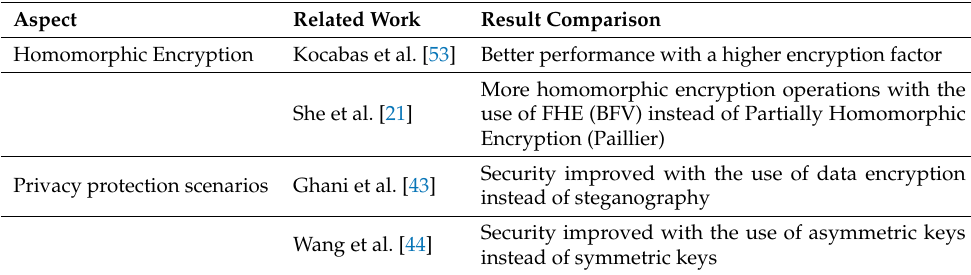
Table 5. Results summary: results compared to related work.